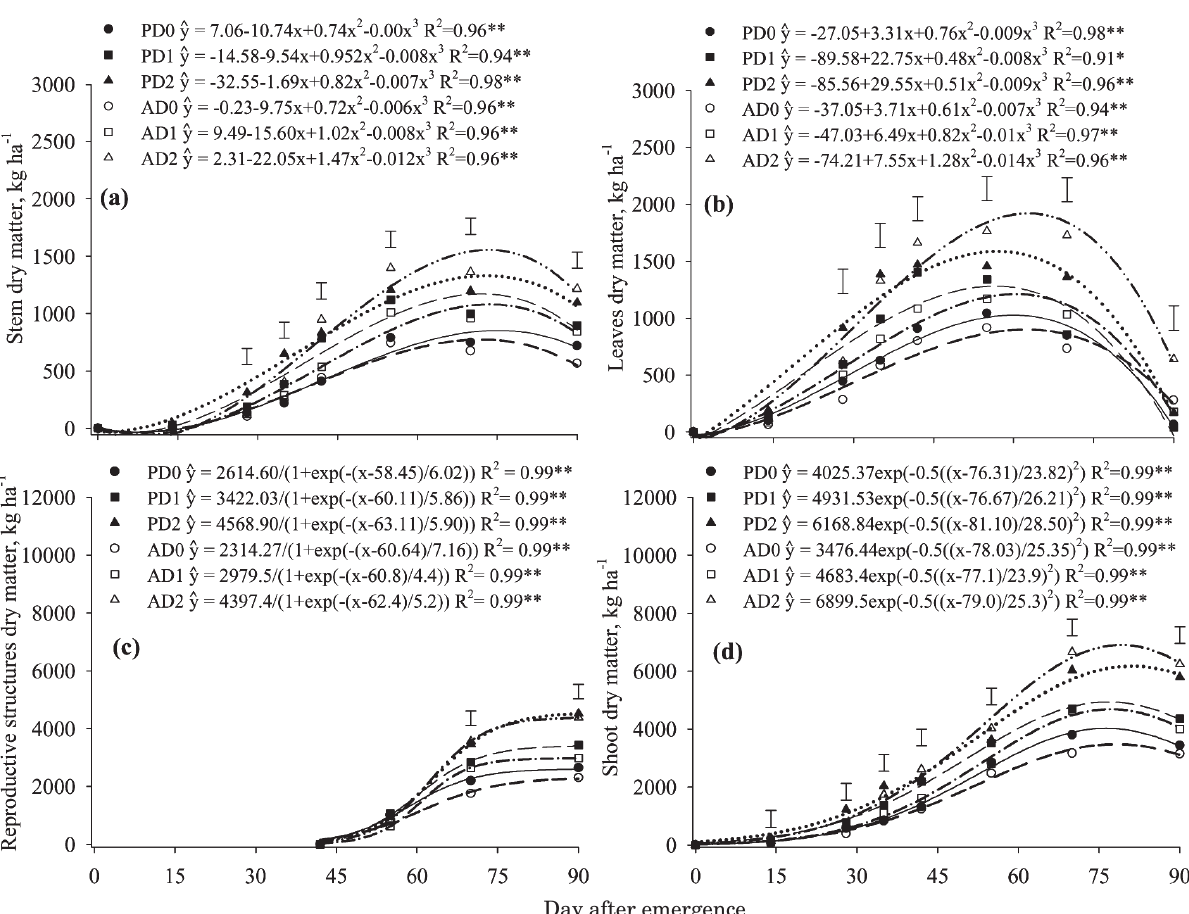
Figure 1. Dry matter accumulation in stem (a), leaves (b), reproductive structures (c), and shoot (d) of common bean cultivars, under different levels of fertilization. ** and * are: significant at p 0.01 and p 0.05 by the F test. Vertical bars represent the Least Significant Difference (LSD) at p 0.05. PD0 = Pérola without NPK fertilization, PD1 = Pérola with 50 % of recommended NPK fertilization; PD2 = Pérola with 100 % of recommended NPK fertilization; AD0 = IAC Alvorada without NPK fertilization, AD1 = IAC Alvorada with 50 % of recommended NPK fertilization; AD2 = IAC Alvorada with 100 % of recommended NPK